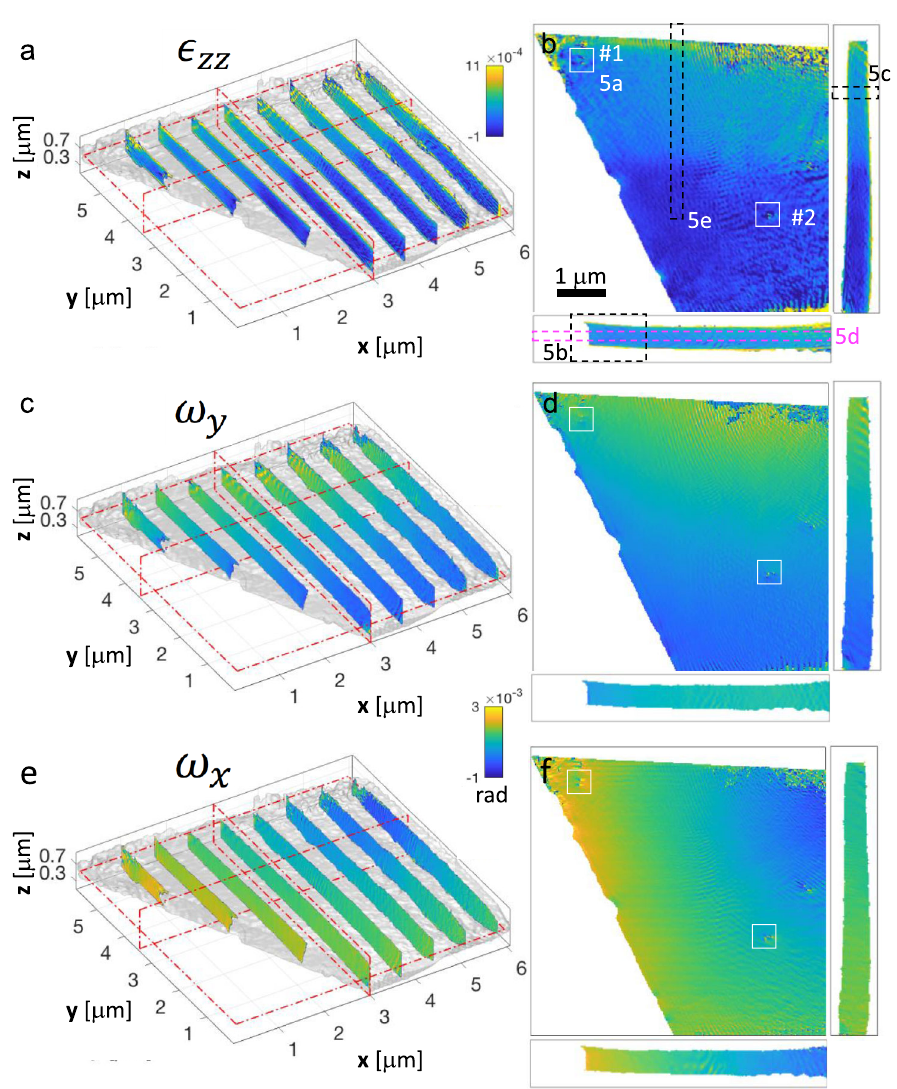
Fig. 4 Strain and tilts revealed in the He-implanted polycrystalline tungsten foil. a 3D iso-surface density plot overlaid with the ε zz strain map, plotted in the ( x , y , z ) laboratory frame. Three planes used for further investigations are indicated as red rectangles. b Cross-sections of the ε zz map extracted over the planes indicated in ( a ). c 3D iso-surface density plot overlaid with the ω y lattice rotation around y -axis. d Cross-sections of ω y extracted over the planes indicated in ( c ). e , f Same as ( c , d ) for the ω x lattice rotation around x -axis. All scale bars and angular colour scales in radian are indicated on